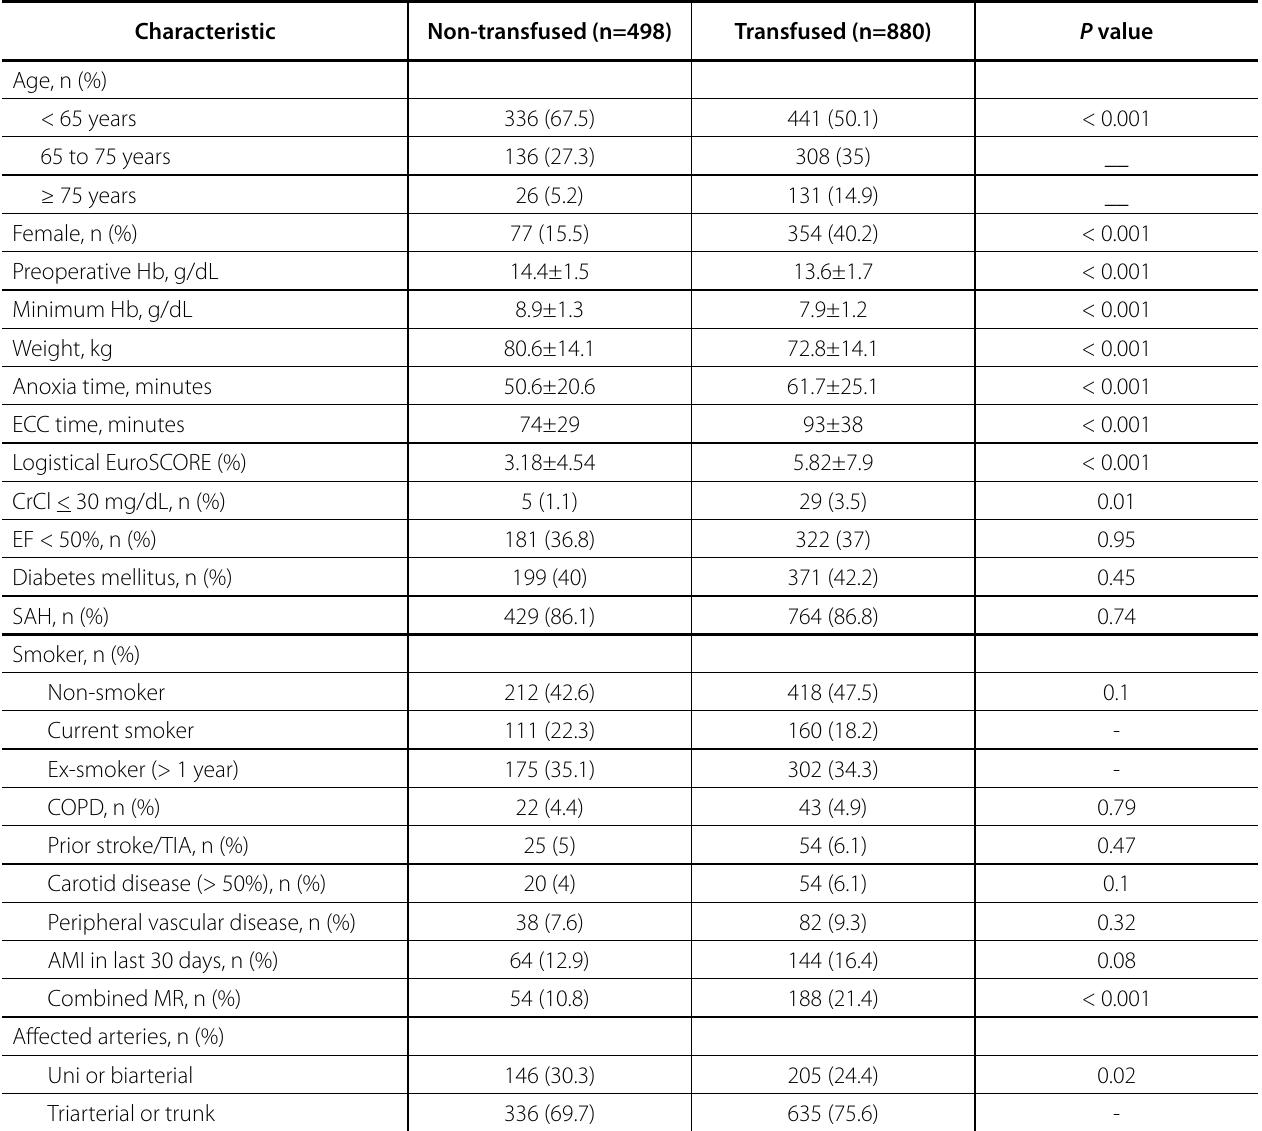
Table 1. Population characteristics